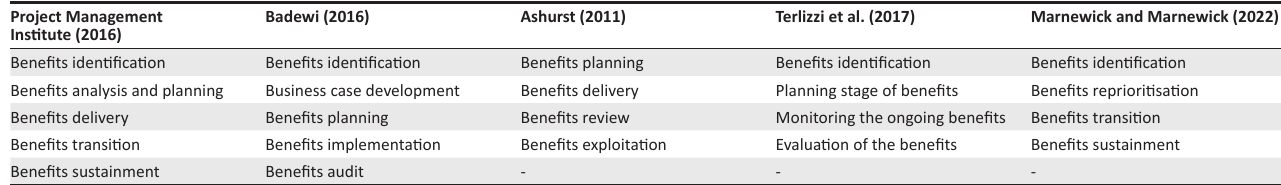
TABLE 1: Comparison of benefits realisation management process. Project Management Institute